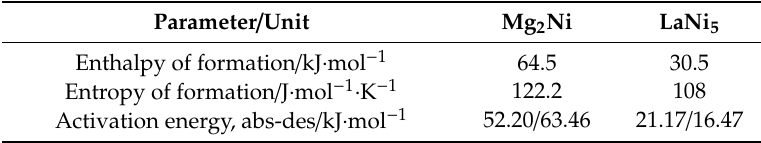
Table 1. Physical parameters used in the model simulation